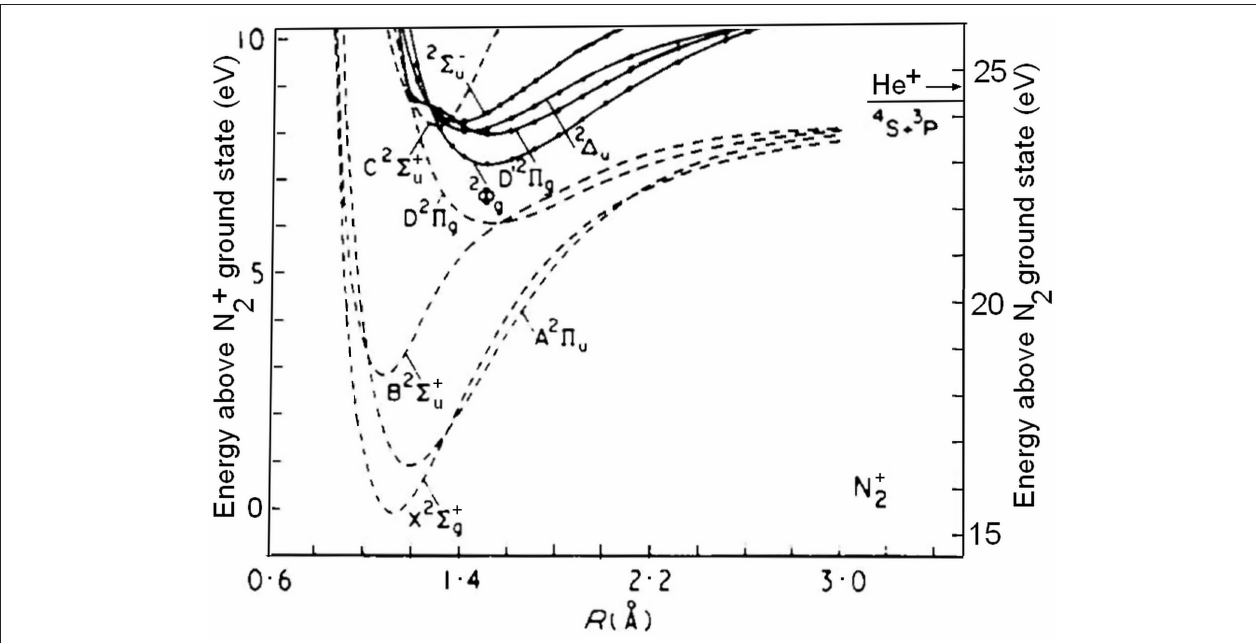
FIGURE 1 | Potential-energy curves for doublet states of N 2 + mentioned in the text. The left-hand ordinate indicates the energy with respect to the N 2 + (X 2 6 + g ) ground-state, the ordinate at the right gives the energy with respect to the ground-state of the neutral molecule. The arrow indicates the recombination energy of He + : 24.5874eV. Adapted from Cartwright and Dunning (1975), whose permission is gratefully acknowledged.